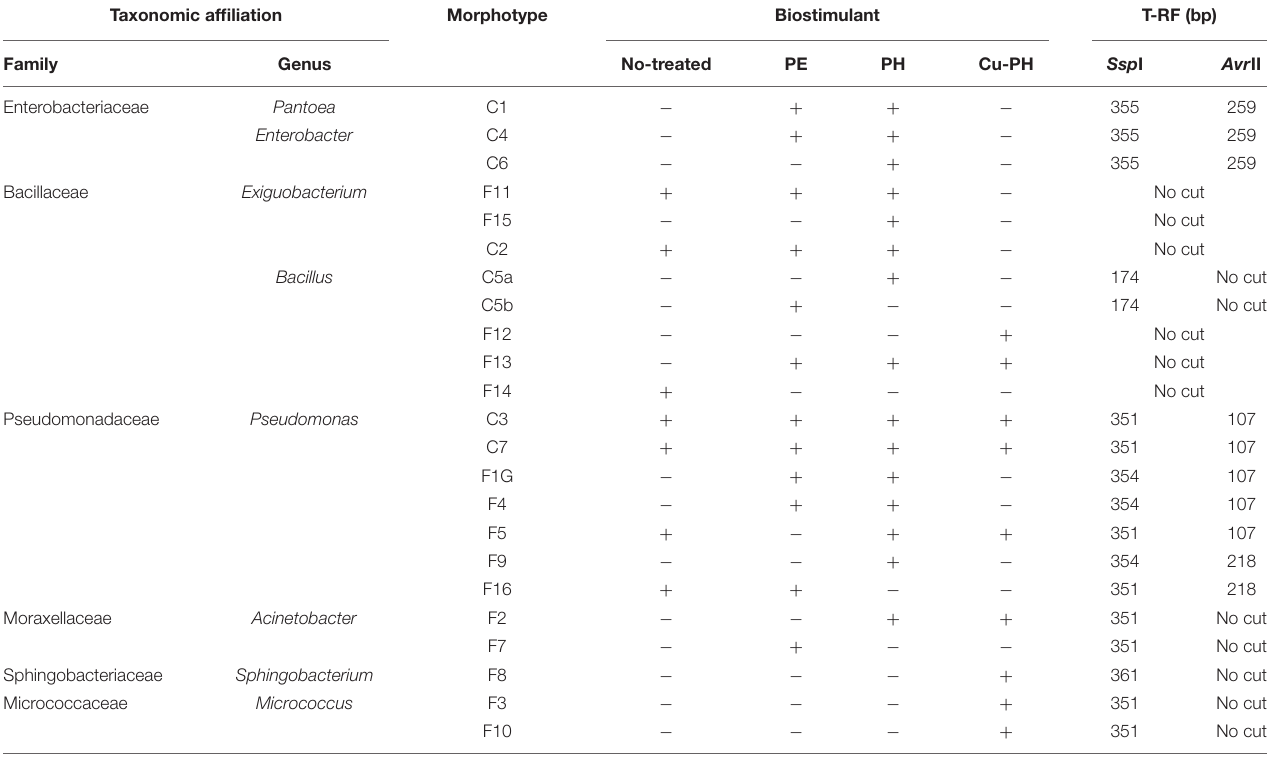
TABLE 3 | Epiphytic bacteria isolated from no-treated and treated lettuce leaves and identified by 16S rRNA